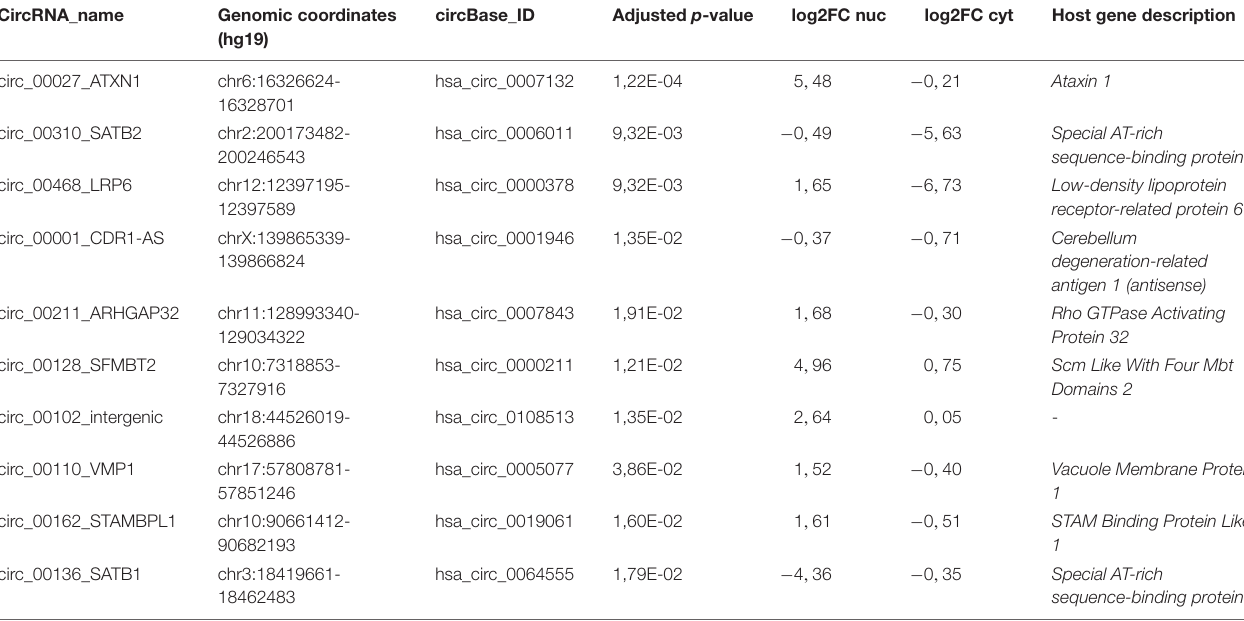
TABLE 2 | List of the 10 most DE circRNAs in the hippocampus of mTLE non-HS patients in comparison to healthy postmortem